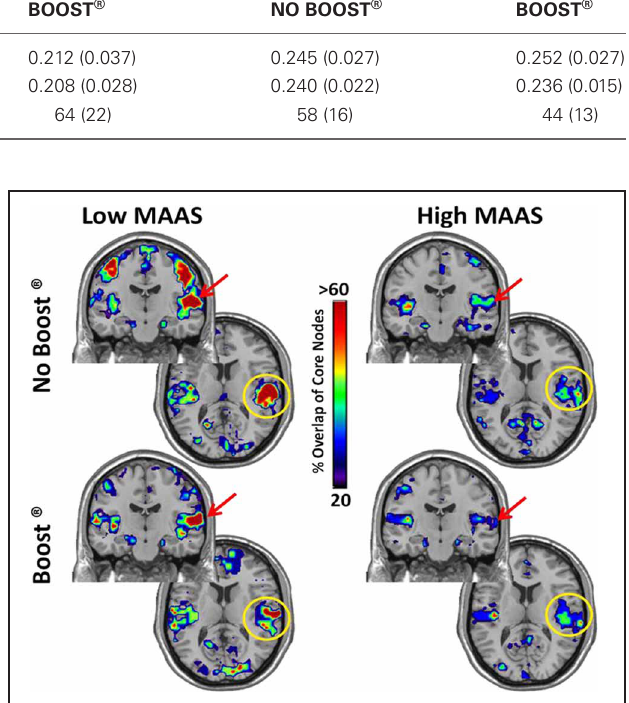
FIGURE 3 | Global Efficiency Maps by MAAS Category: Insula/Auditory Cortex. This figure shows a coronal and axial section of the brain for each group and condition to highlight the insula/auditory cortex. The insula/auditory cortex consistently exhibited high global efficiency in the Low MAAS group under both conditions.